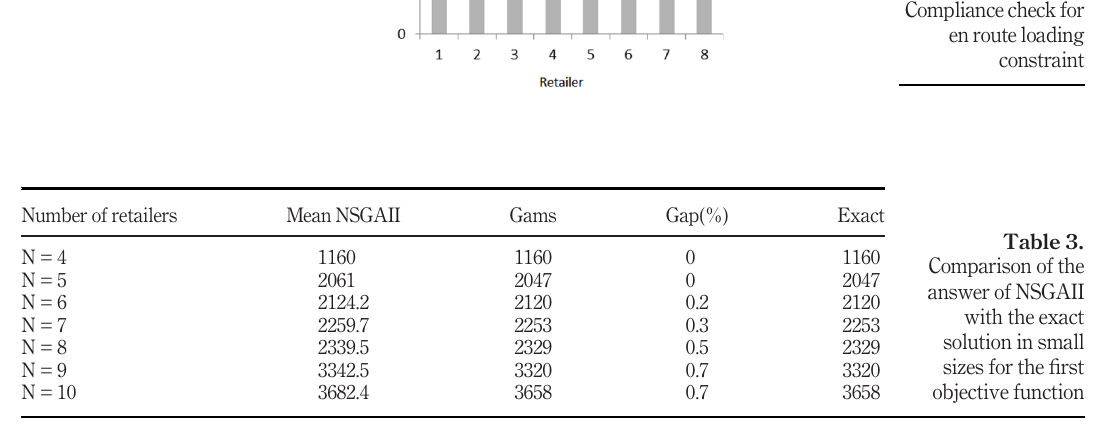
Figure 8. Compliance check for